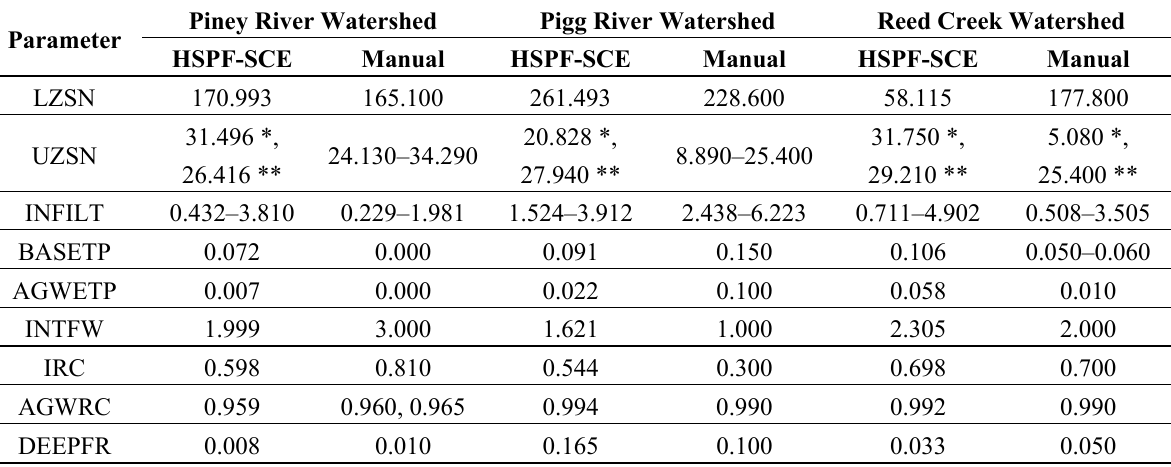
Table 7. Comparison of parameter values calibrated by HSPF-SCE and